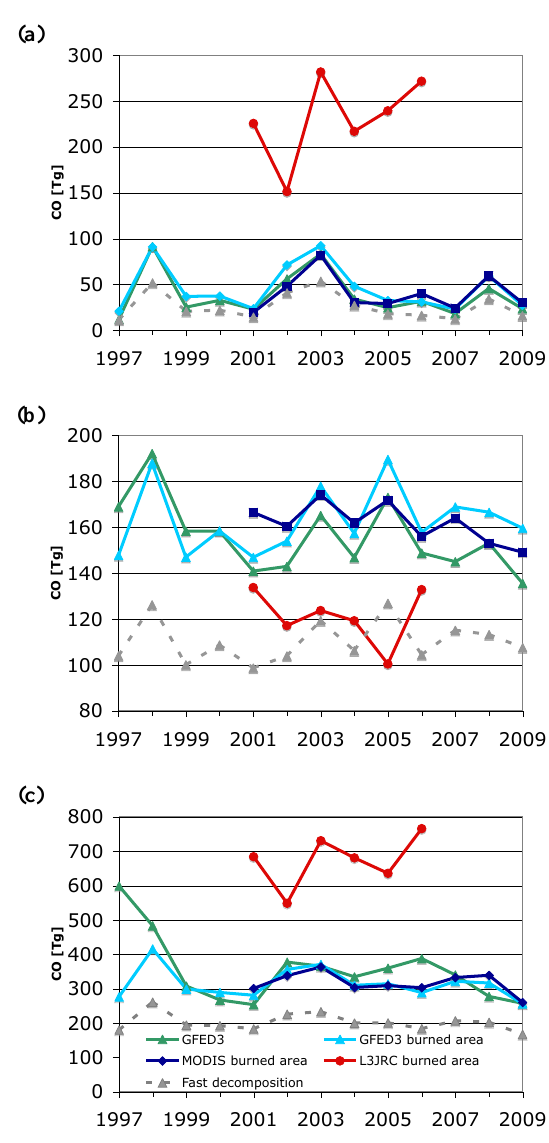
Fig. 4. Annual CO emissions inTg for c w = 0 . 2 and Emission Model 1, for different burned area data sets and for fast litter decom- position, as well as GFED3 emissions. (a) Boreal Asia and North America. (b) Africa. (c)